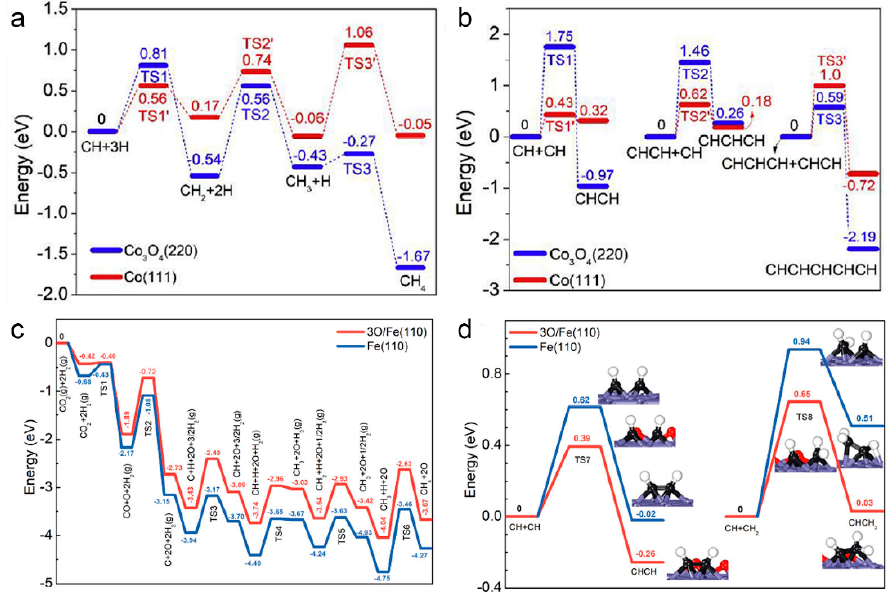
Figure 4 . The potential energy profile of ( a ) CH 4 formation and ( b ) C − C coupling on Co 3 O 4 (220) and Co (111). Reprinted with permission from ref. [52]. Copyright 2019 Elsevier. The potential-energy profiled of the possible pathways for CO 2 conversion on 3O/Fe (110) and Fe (110). ( c ) CH 4 formation and ( d ) C − C coupling reactions. The insets in ( d ) show the configurations of the transition and final states of C − C coupling. The blue, black, red, and white spheres represent Fe, C, O, and H atoms, respectively. Reprinted with permission from ref. [9]. Copyright 2021 Wiley-VCH.